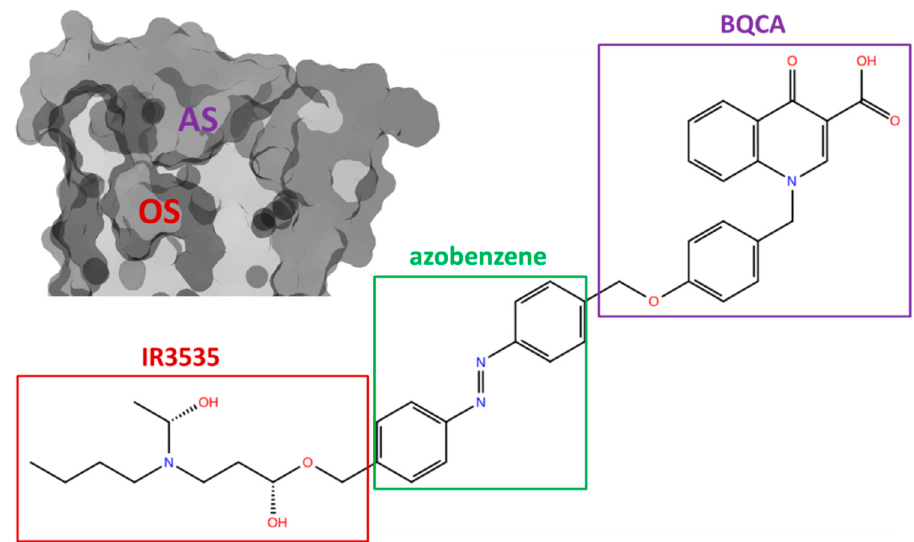
Figure 7. Structure of the bitopic, photoswitchable insect repellent BQCA-azo-IR3535 with parts that target orthosteric (OS, red) and allosteric (AS, violet) sites of the muscarinic acetylcholine receptor (left side) indicated in red and purple boxes,